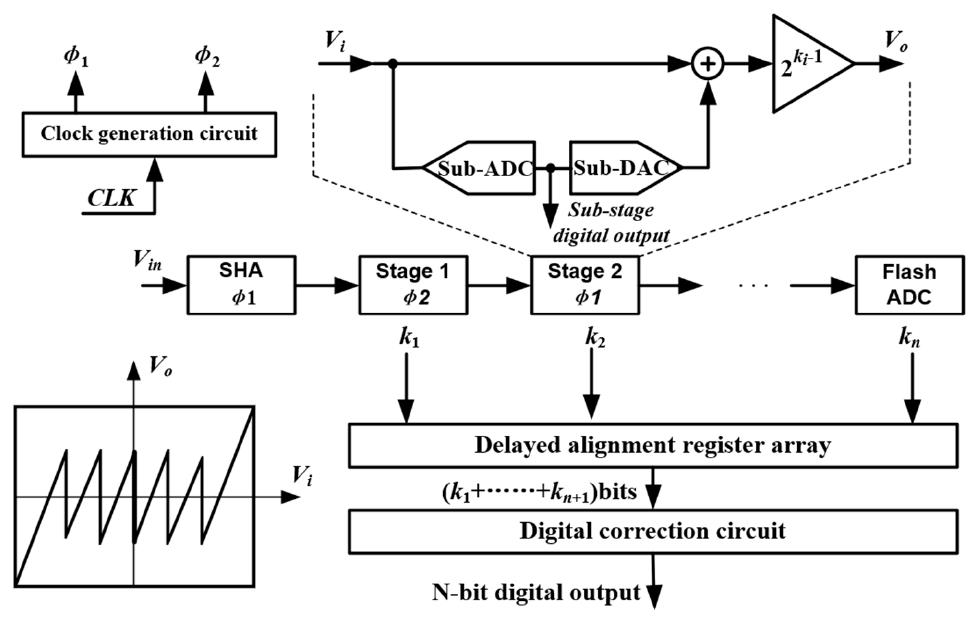
Figure 12. Basic structure diagram of pipelined ADC.